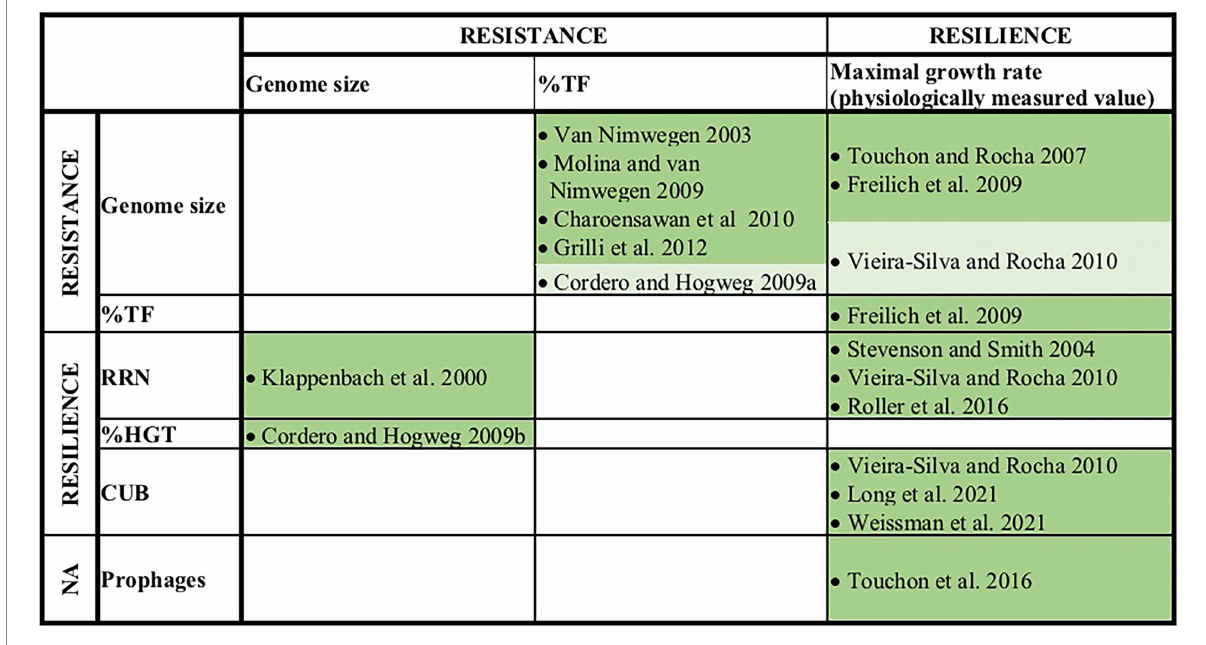
FIGURE 2 Earlier reported pairwise correlations among genomic traits and/or physiologically measured maximum growth rates. Traits that were in this study assigned as resistance or resilience related traits are indicated. Dark green fields indicate positive significant correlations ( p < 0.05) and light green field indicates a positive trend below the significance level (0.5 > p >